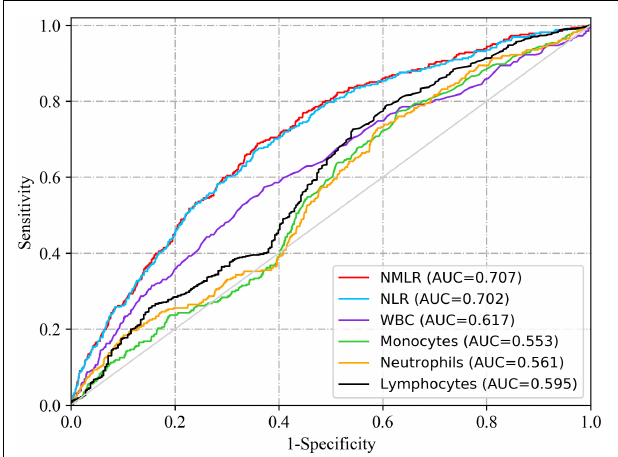
FIGURE 2 | ROC curves of indicators related to peripheral differential leukocyte counts for predicting in-hospital mortality. The solid red line indicates the ROC curve of admission NMLR. The AUCs of admission NMLR and NLR were better than those of others. The follow-up DeLong’s test revealed